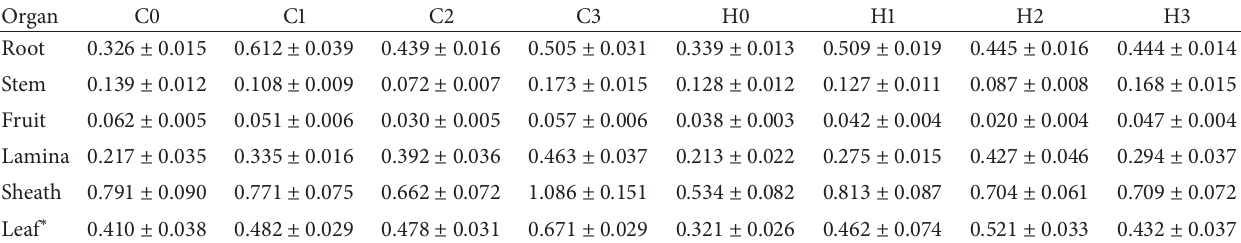
Table 5: Cd concentrations in different parts of different treatments (mg/kg). All values are mean ± SD ( 𝑛 = 3